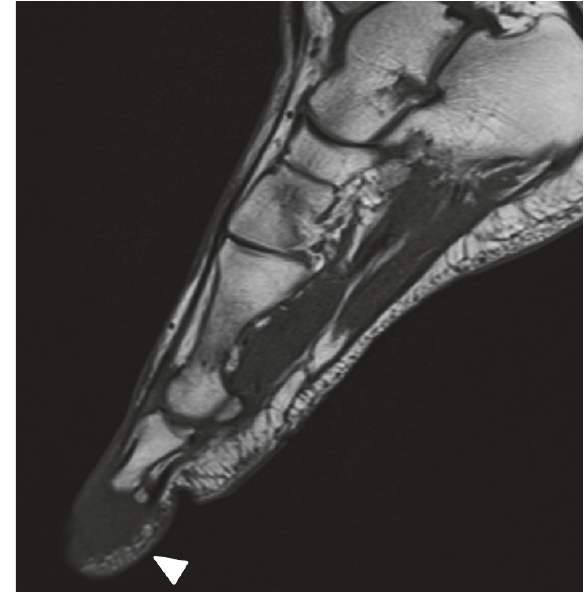
Figure 3: T1-weighted magnetic resonance imaging of the left foot shows low intensity in the first distal phalanx.